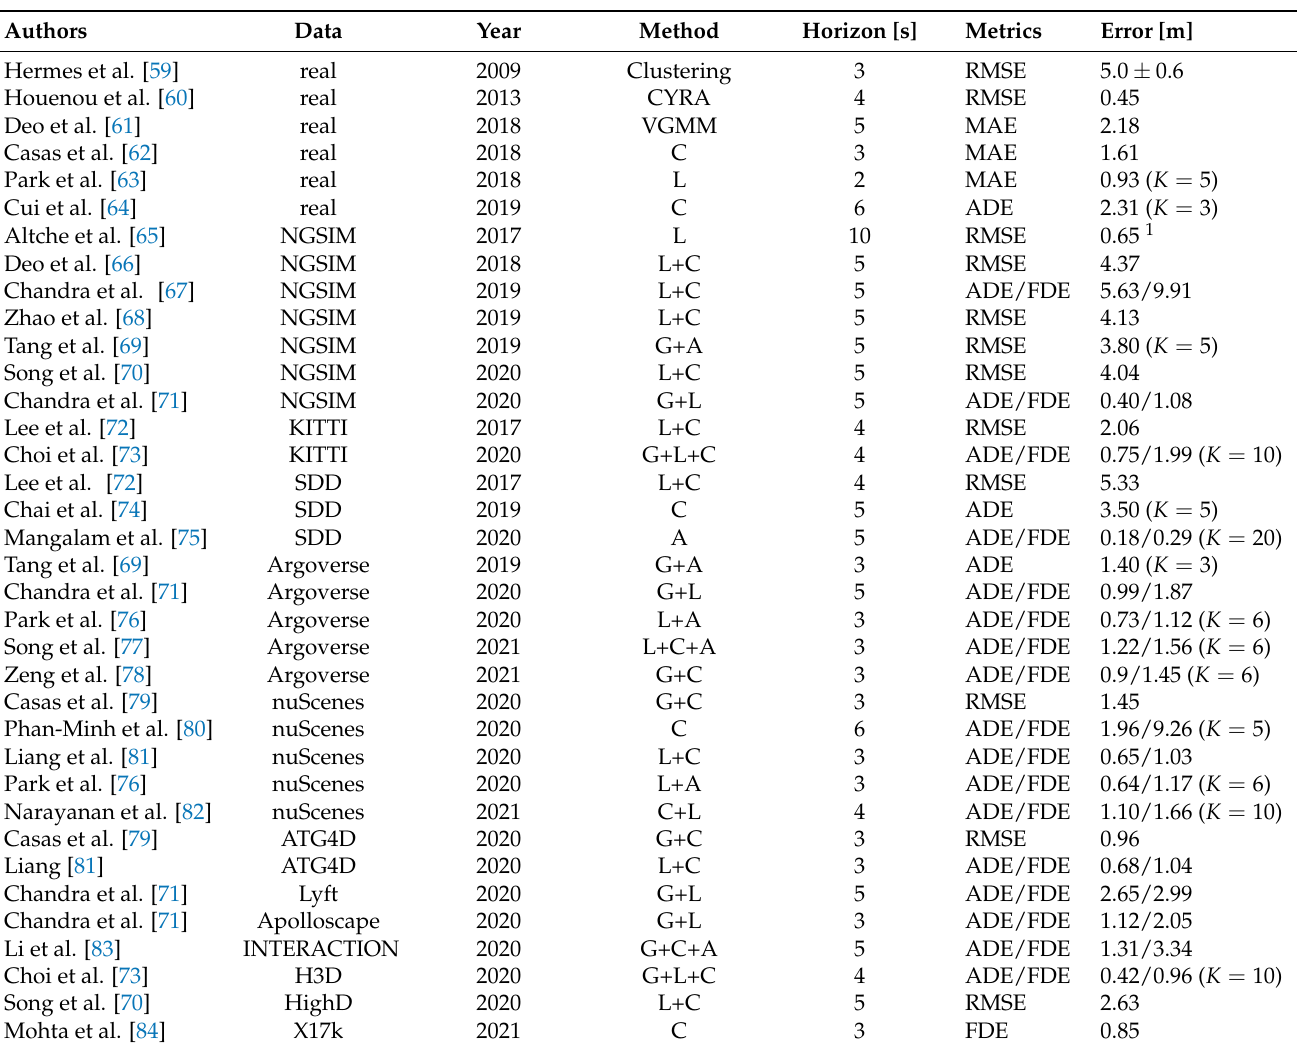
Table 1. Overview of publications on scene prediction for AD. Neural network models are grouped under “L” (LSTM/GRU), “C” (CNN), “G” (GNN), and “A” (Attention). Some papers are also available at [58]. For the error it is specified the number of modes, K , over which the prediction is sampled, if applicable. See abbreviations